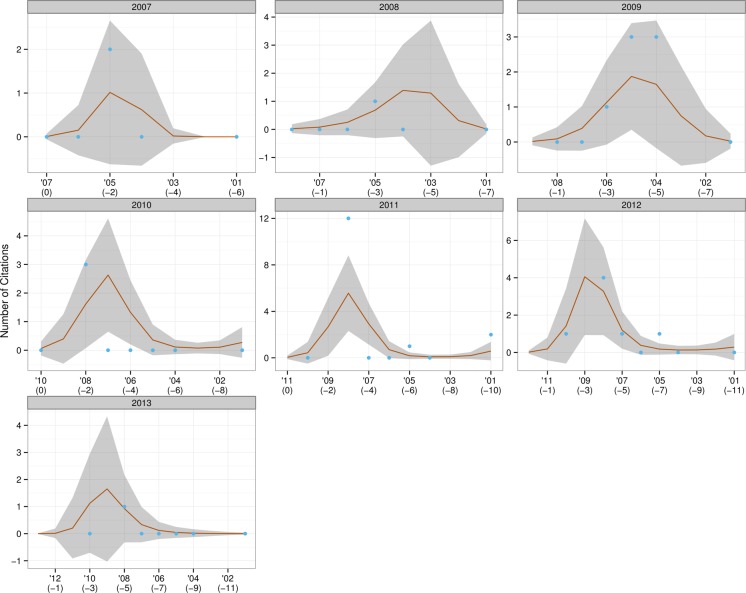
Trends in citations for doctoral dissertations.